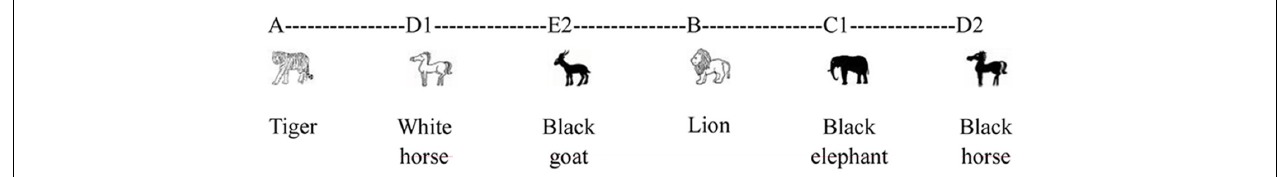
FIGURE 3 | Sample of cross-modal stimuli presentation in Experiment 2. The animal pictures were the visual stimuli, and the animal names were the auditory stimuli presented in Chinese.